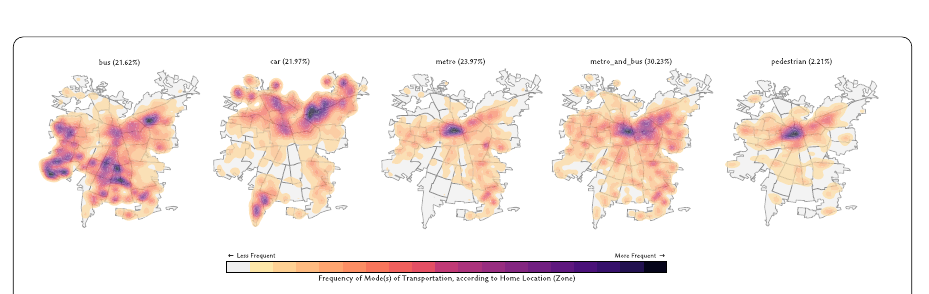
Figure 11 Heatmaps of home location (based on traffic analysis zones) with respect to mode of transportation, estimated with Kernel Density Estimation. Note that to ease interpretation the first level of the estimation has been